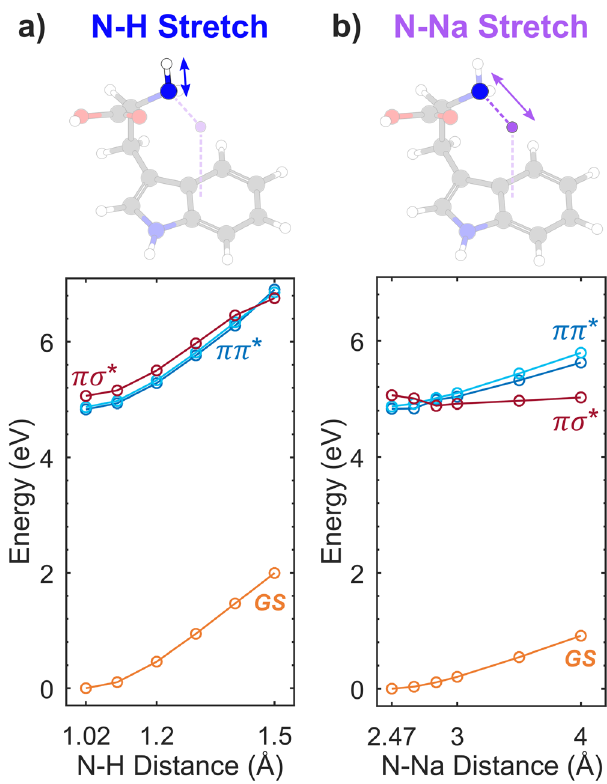
Fig. 4 Reactive potential energy surfaces in sodiated tryptophan. Computed potential energy surfaces for TrpNa + , along the N – H ( a ) and N – Na ( b ) stretching modes, depicted by the geometries on top. The ground state equilibrium geometry corresponds to R NH = 1.02 Å and R NNa = 2.47 Å. The πσ * state is displayed in red, ππ * states are displayed in blue, and the ground state is displayed in